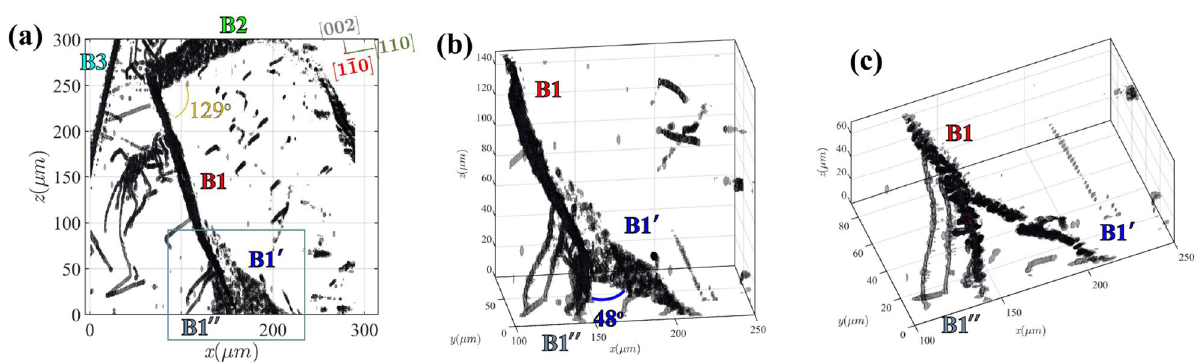
Figure 5. (a) Projection of the 3D dislocation structures shown in Fig. 4 along the crystallographic [ 1 ¯ 10 ] vector, showing the angles between each boundary plane. With this perspective, the space between B3 and the intersection of B1 and B2 is clearer, as well as the curvature of the boundaries when B1 and B1 ′ split, near the bottom. (b) A zoomed-in and rotated perspective of the junction between B1 and B1 ′ , showing the triple- junction formed by the two planes adjoining. Angle between planes is labeled. (c) Projection of the boundary off-crystallographic axis, showing the curvature and discontinuity of B1 ′ and the component dislocations. The figure is made using the MATLAB code in the link https:// github. com/ leora dm/ Dislo catio n3DAn alysis. the junction suggests the innermost dislocation has the highest energy, thereby distorting the topology of the boundary planes at that site. Boundary identification. Beyond B1 and B1 ′ , Fig. 5 shows two other boundaries that are clearly defined in the high- z regions of the dislocation structures. Another boundary, B2 (green), intersects B1 in the upper ∼ 50 µ m z region of the volume, intersecting at an angle of 129 ◦ (Fig. 5a). B2’s plane is defined by its [¯ 201 ] normal